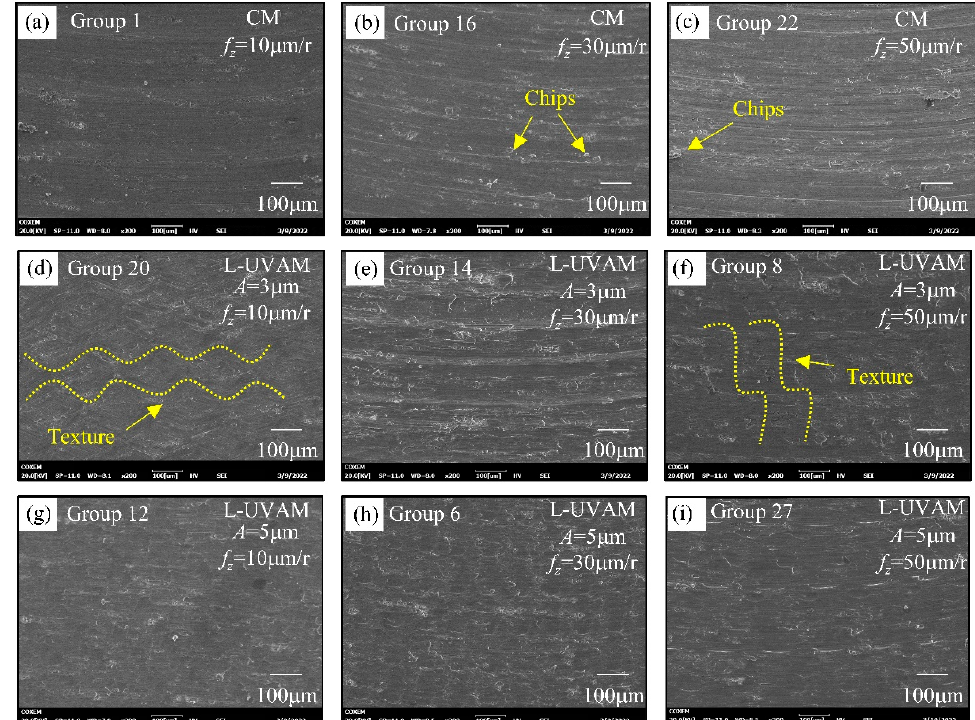
Figure 10. Effect of feed per tooth on the surface morphology of Conventional Milling (CM) and Longitudinal Torsion - Ultrasonic Vibration Assisted Milling (L-UVAM). ( a ), ( b ) and ( c ) Effect of Longitudinal Torsion - Ultrasonic Vibration Assisted Milling (L-UVAM). ( a – c ) Effect of increasing feed increasing feed per tooth on surface topography in CM; ( d ), ( e ) and ( f ) Effect of ultrasonic vibration per tooth on surface topography in CM; ( d – f ) Effect of ultrasonic vibration amplitude A = 3 µ m on amplitude A =3 μ m on surface morphology; ( g ), ( h ) and ( i ) Effect of ultrasonic vibration amplitude surface morphology; ( g – i ) Effect of ultrasonic vibration amplitude A = 5 µ m on surface A =5 μ m on surface morphology.